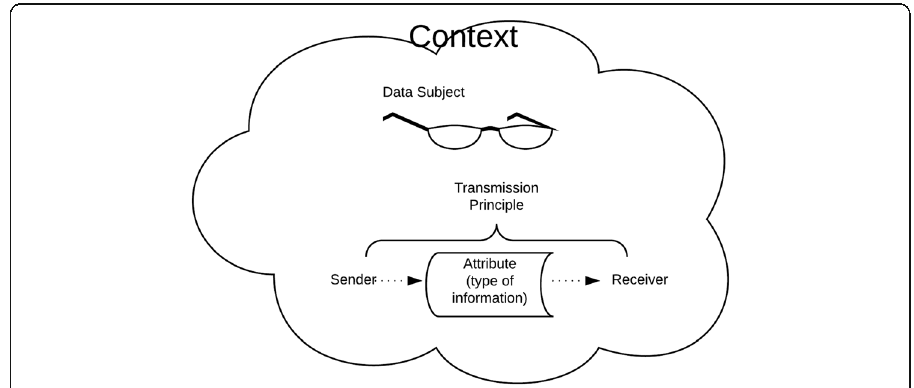
Fig. 3 The theory of contextual integrity (after Nissenbaum,